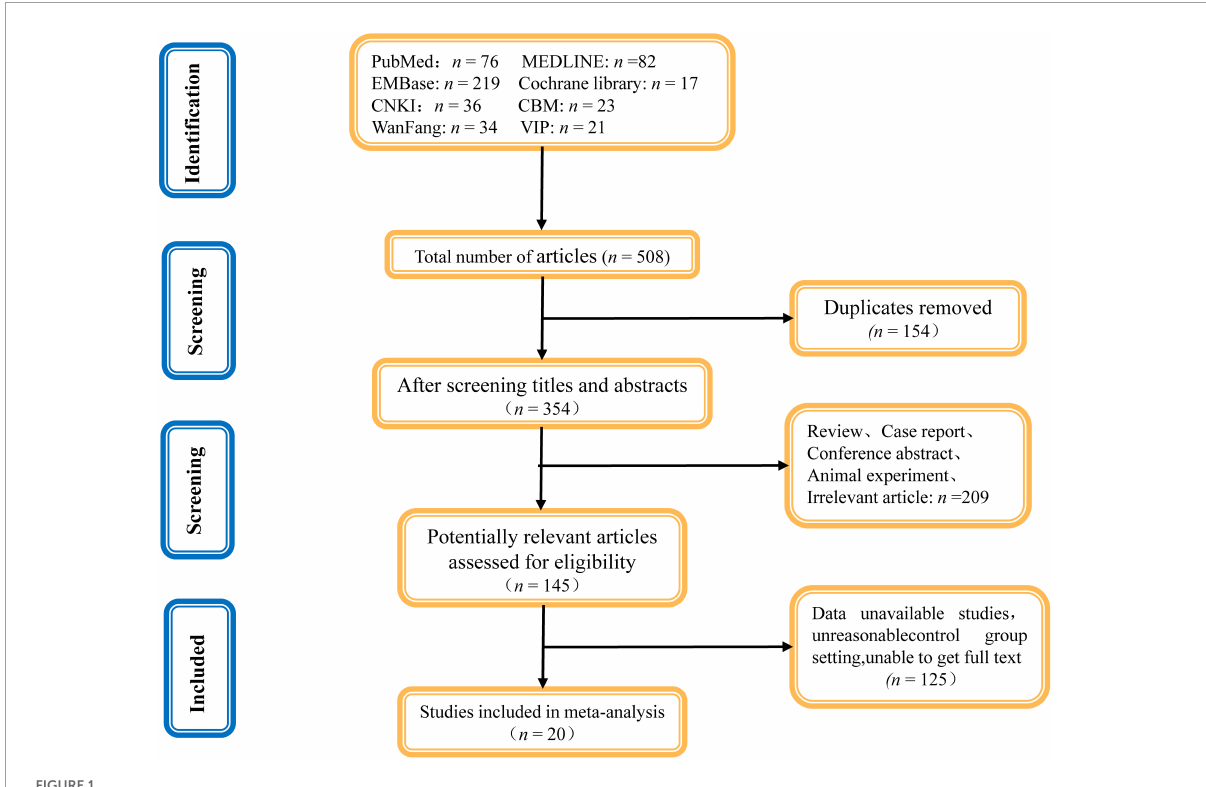
FIGURE1 Literature screening